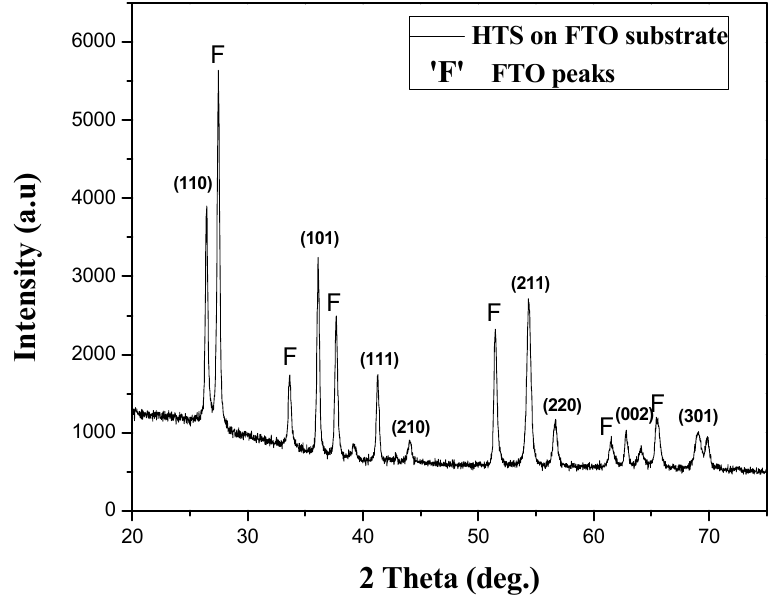
Figure 2. X-ray diffraction pattern of hierarchical TiO 2 structure on fluorine doped tin oxide (FTO) glass